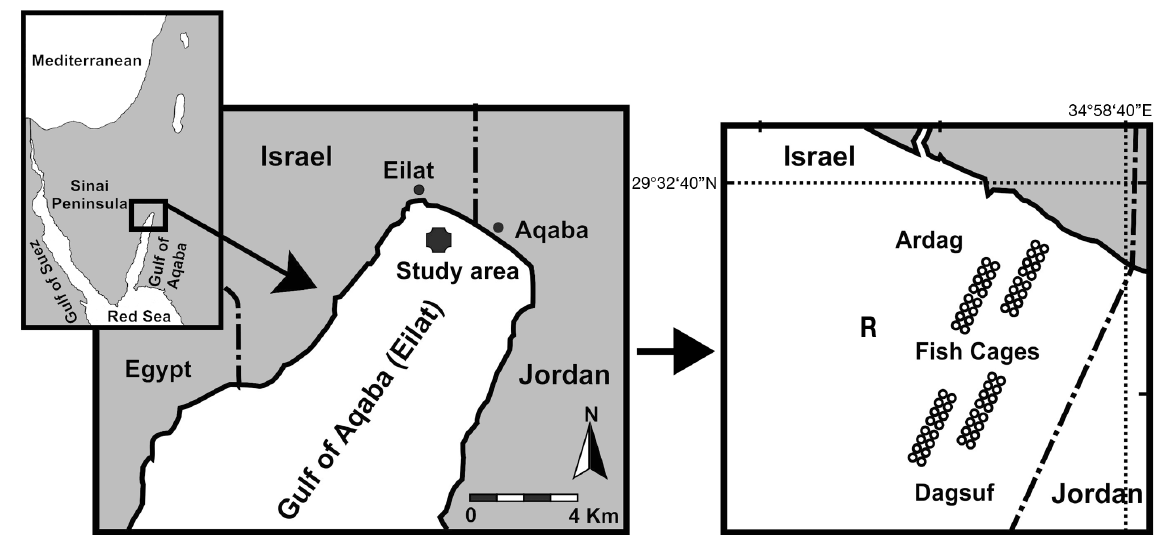
Fig. 1. Location of the study area at the northern end of the Gulf of Aqaba, Red Sea. The sandy seafloor in this area has few solid substrates (e.g. concrete moorings or debris associated with the fish farms, shown in Fig. 2) and there were no coral reefs near the fish farms. ‘R’ indicates the location of the reference station, ca. 500 m west of the fish